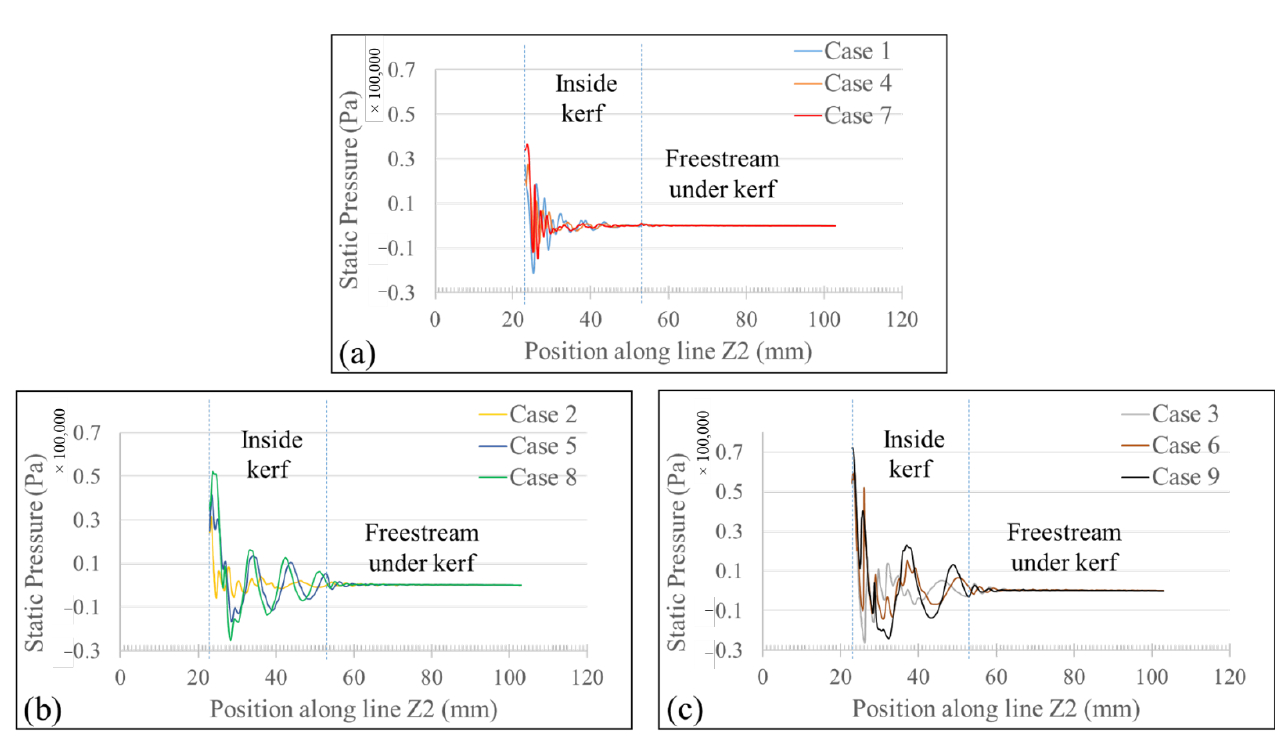
Figure 18. Pressure distribution curve along line Z2 for various kerf geometry: ( a ) cases 1, 4 and 7; ( b ) cases 2, 5 and 8; and ( c ) case 3, 6 and 9.